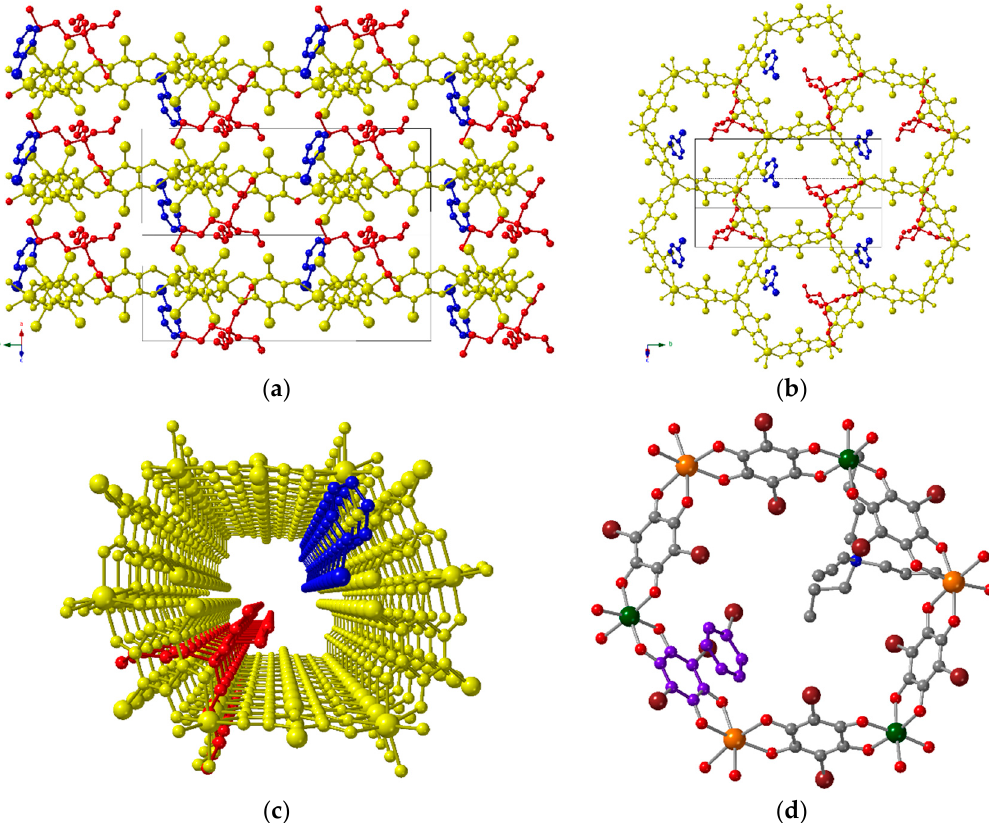
Figure 5. Structure of (NBu 4 )[MnCr(C 6 O 4 Br 2 ) 3 ]·C 6 H 5 Br·0.5H 2 O ( A ). ( a ) Side view of the alternating cationic (in red) and anionic (in yellow) layers. The solvent molecules are depicted in blue. ( b ) Top view of the honeycomb layer [same color code as in ( a )]. ( c ) Perspective view of the hexagonal channels [same color code as in ( a )]. ( d ) View of one hexagon showing the π – π interactions between the aromatic ring and one anilato ring (in purple). Color code: Mn = orange, Cr = dark green, C = grey, O = red, N = dark blue, and Br = brown. The H atoms were omitted for clarity.